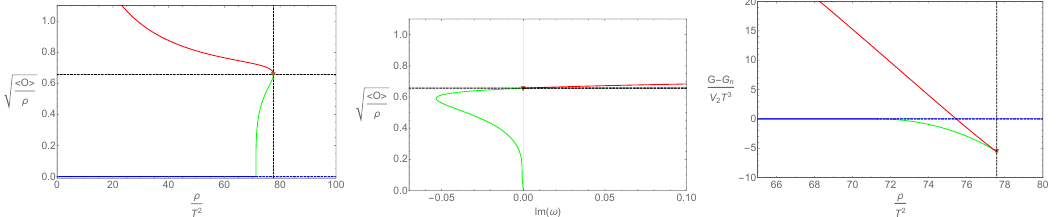
Figure 2 . A typical zeroth order phase transition. Left : the normalized scalar condensate as a function of the dimensionless charge density. Middle : the imaginary part of the amplitude mode of the superfluid phase. Right : the Gibbs free energy difference between the normal phase and the superfluid phase. All figures are for λ = − 0 . 8 , τ = 0 and m 2 = − 2 , q = 1 . The brown triangle indicates the position of the turning point at ρ = ρ t